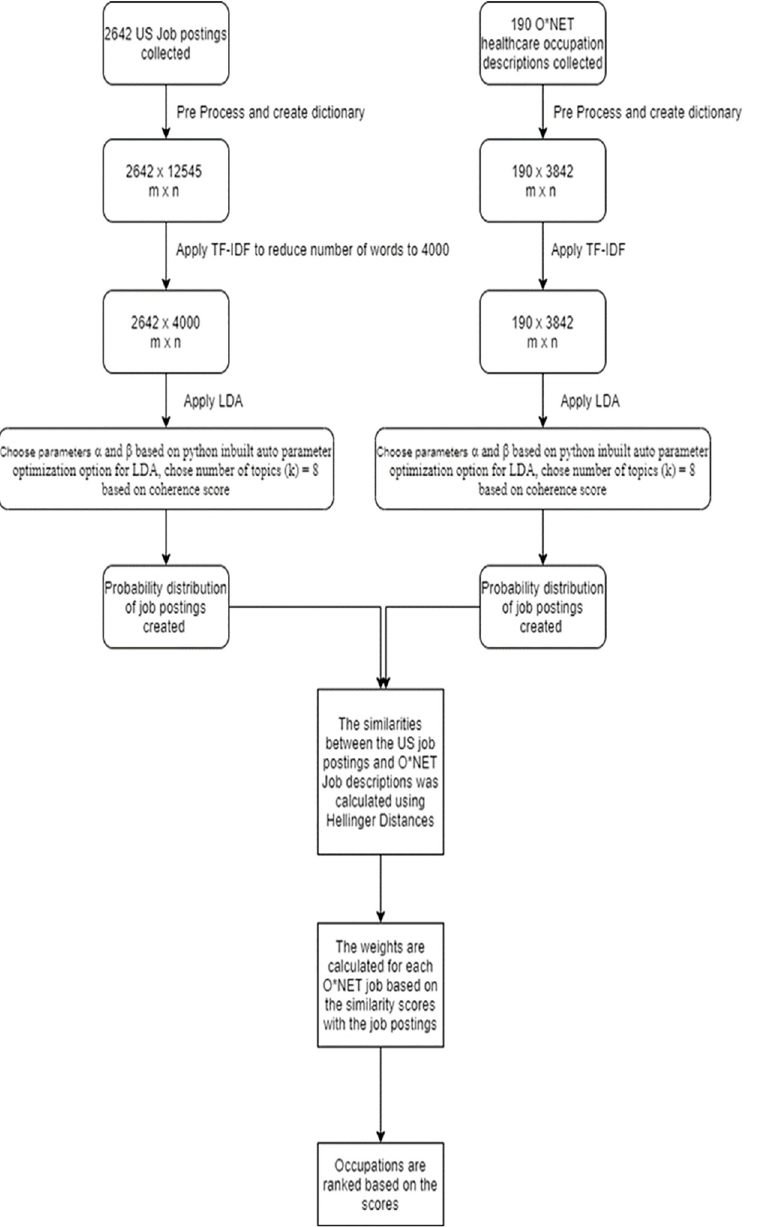
Fig 4. Schematic representation of the methodology used for Approach